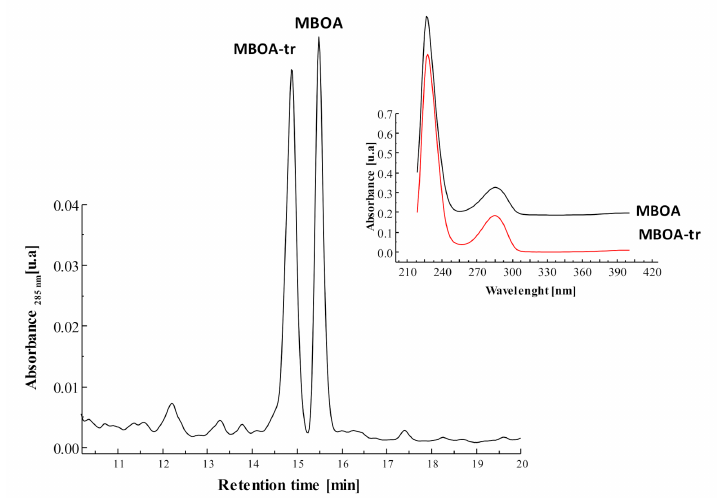
Figure 2. Chromatographic analysis of root extract of L. rigidum L. and comparative analysis of the UV-Vis spectra of MBOA and MBOA-tr. Conditions: 8 days of growth, 3 mM